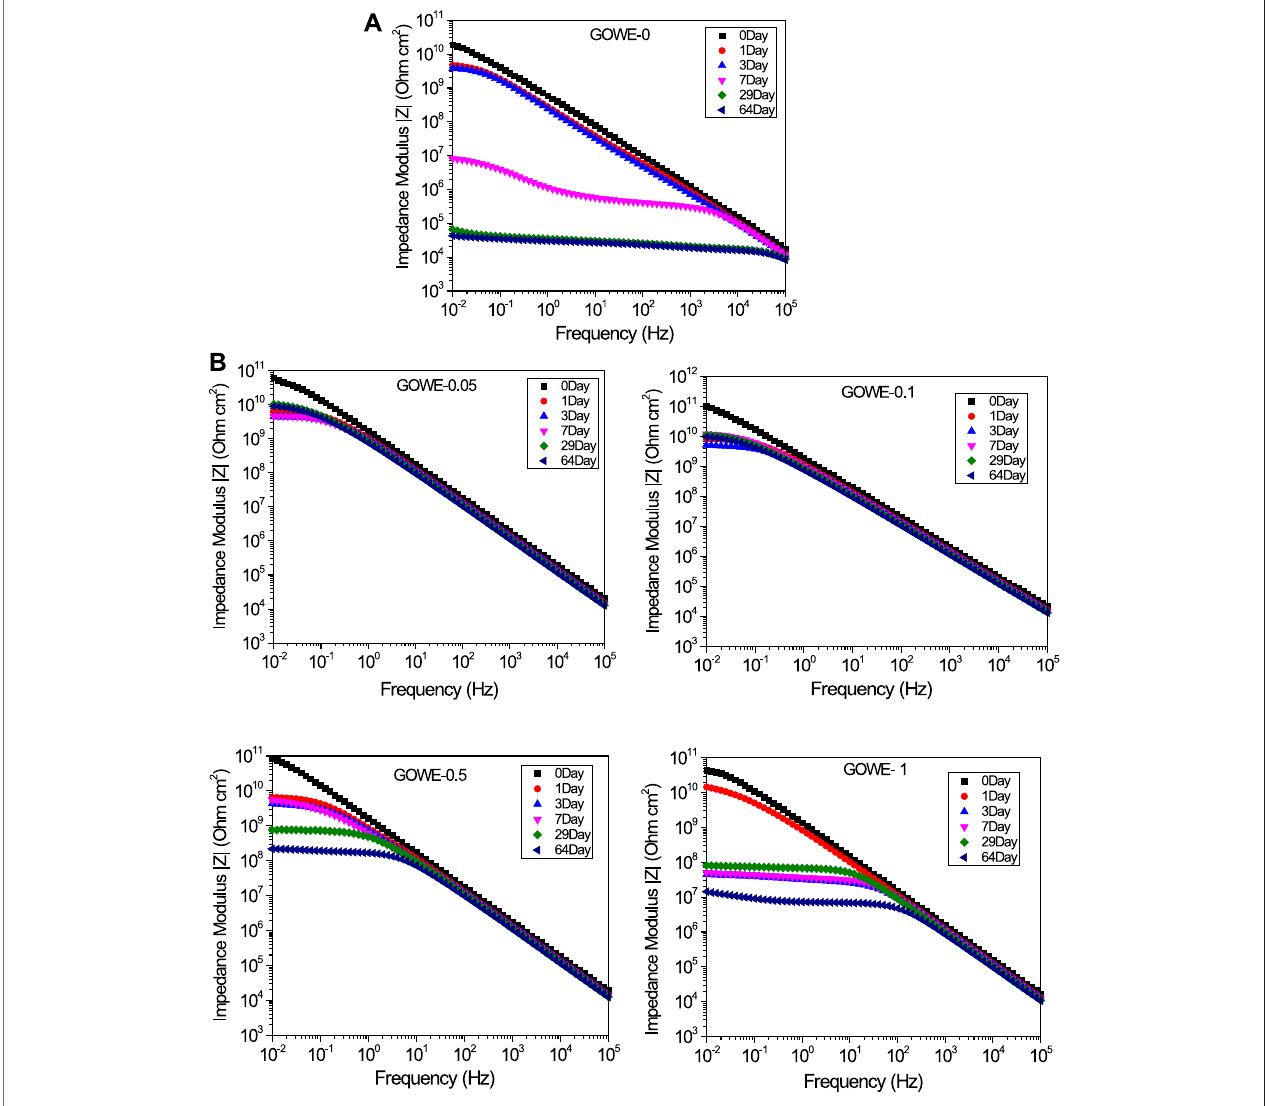
FIGURE 2 | (A) Bode plots of neat waterborne epoxy coating GOWE-0 (without graphene oxide) in the immersion of 3.5 wt% NaCl solution; and (B) Bode plots of GOWEcoatings(GOWE-0.05,GOWE-0.1,GOWE-0.5,andGOWE-1)intheimmersionof3.5 wt%NaClsolution.TheformulationofGOWEcoatingsislistedin Table1 .